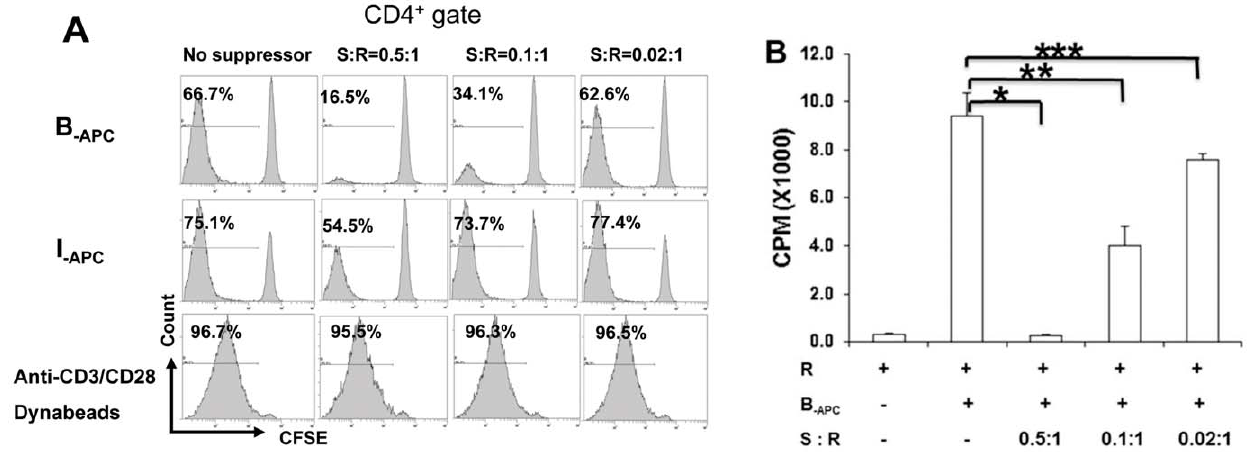
Figure 2. Invitro expanded CD8 + CD28 2 T cells suppress CD4 + T cells proliferation in a donor-specific manner. CD8 + T cells from donor A were stimulated with APCs from donor B plus c c cytokines for 9 days, followed by enrichment of the CD8 + CD28 2 population as described in Materials and Methods . 5 6 10 4 CFSE labeled purified responder CD4 + T cells (R) from donor A were stimulated with 5 6 10 4 APCs from donor B (B- APC ) or from an indifferent donor (I- APC , HLA-A, B and DR fully mismatched with donor B), or 1 6 10 4 anti-CD3/CD28 coated Dynabeads in triplicates in 96- well plates. The in vitro expanded CD8 + CD28 2 T cells were added as putative suppressors (S) at S:R ratios of 0.5:1, 0.1:1 and 0.02:1 (with the cell number of ‘‘R’’ kept constant). Proliferation of the CD4 + cells was measured by CFSE dilution ( A ) or by 3 H thymidine uptake ( B ). Data shown are representative of three independent experiments. * P =0.002; ** P =0.009; *** P =0.008.